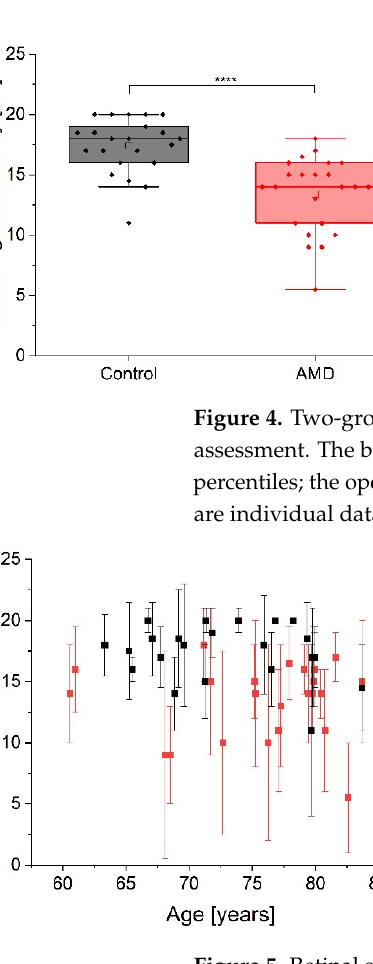
Figure 5. Retinal sensitivity to visible (left panel) and infrared light (right panel) as a function of age. The median value over 44 points assessed in each AMD (red) and control (black) subject was taken. Error bars = interquartile range.